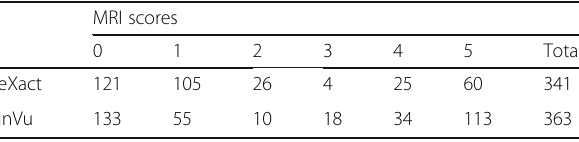
Table 7 Frequency distribution and the result of the χ 2 analysis of the modified remnant index (MRI) after debonding